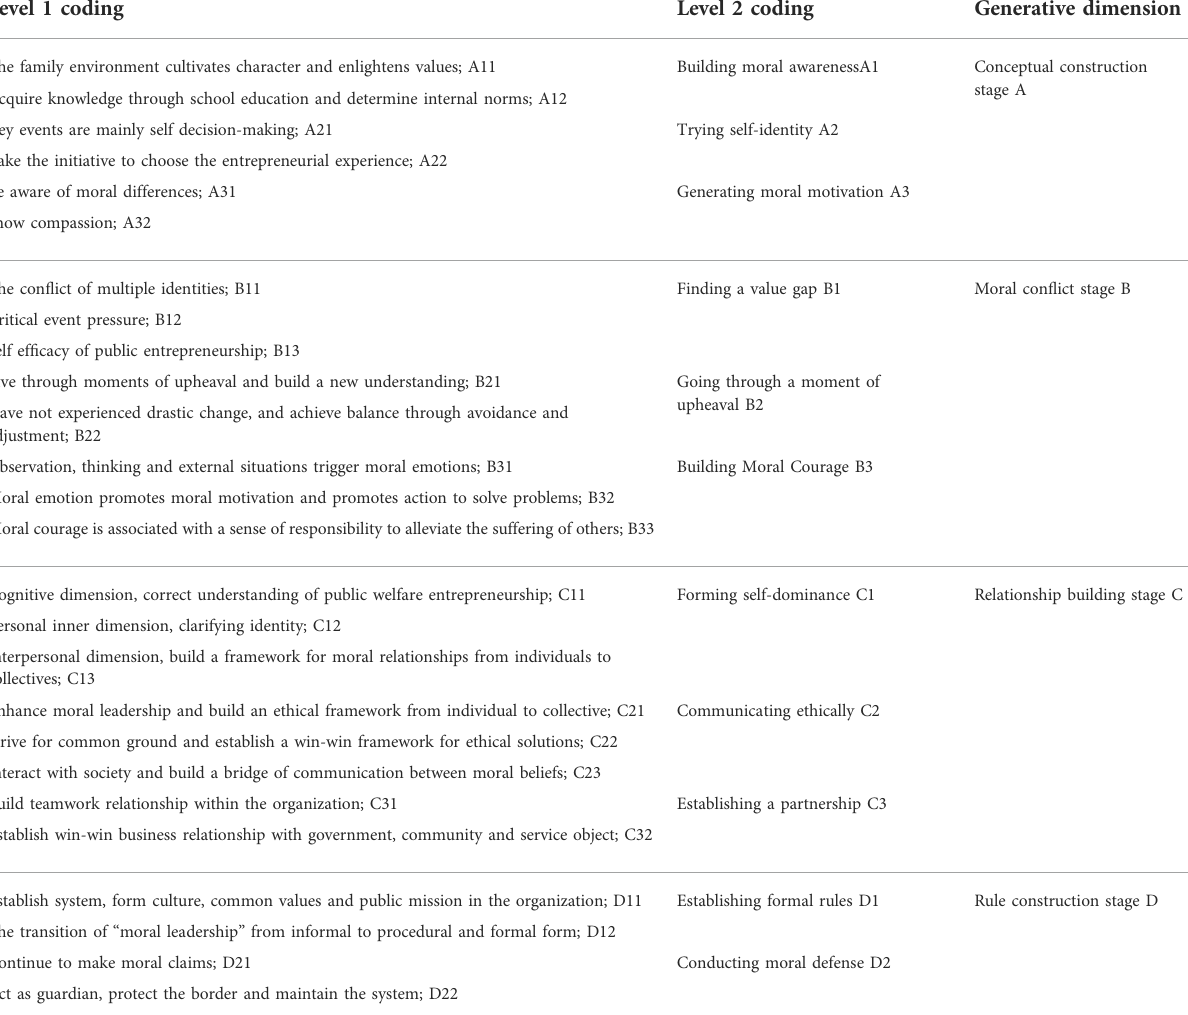
TABLE 2 Key construction and measurement